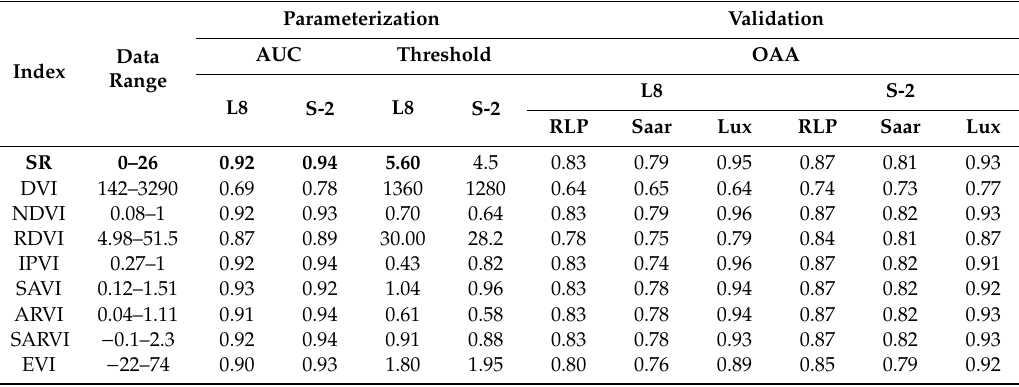
Figure 6. Forest Type map based on Landsat 8 data from 2014, updated with Sentinel-2 imagery from 2017 and 2018. Table 5. Parameterization to receive the optimal threshold (area under the ROC curve) and comparison of the received OAA based on Landsat 8 and Sentinel-2 derived